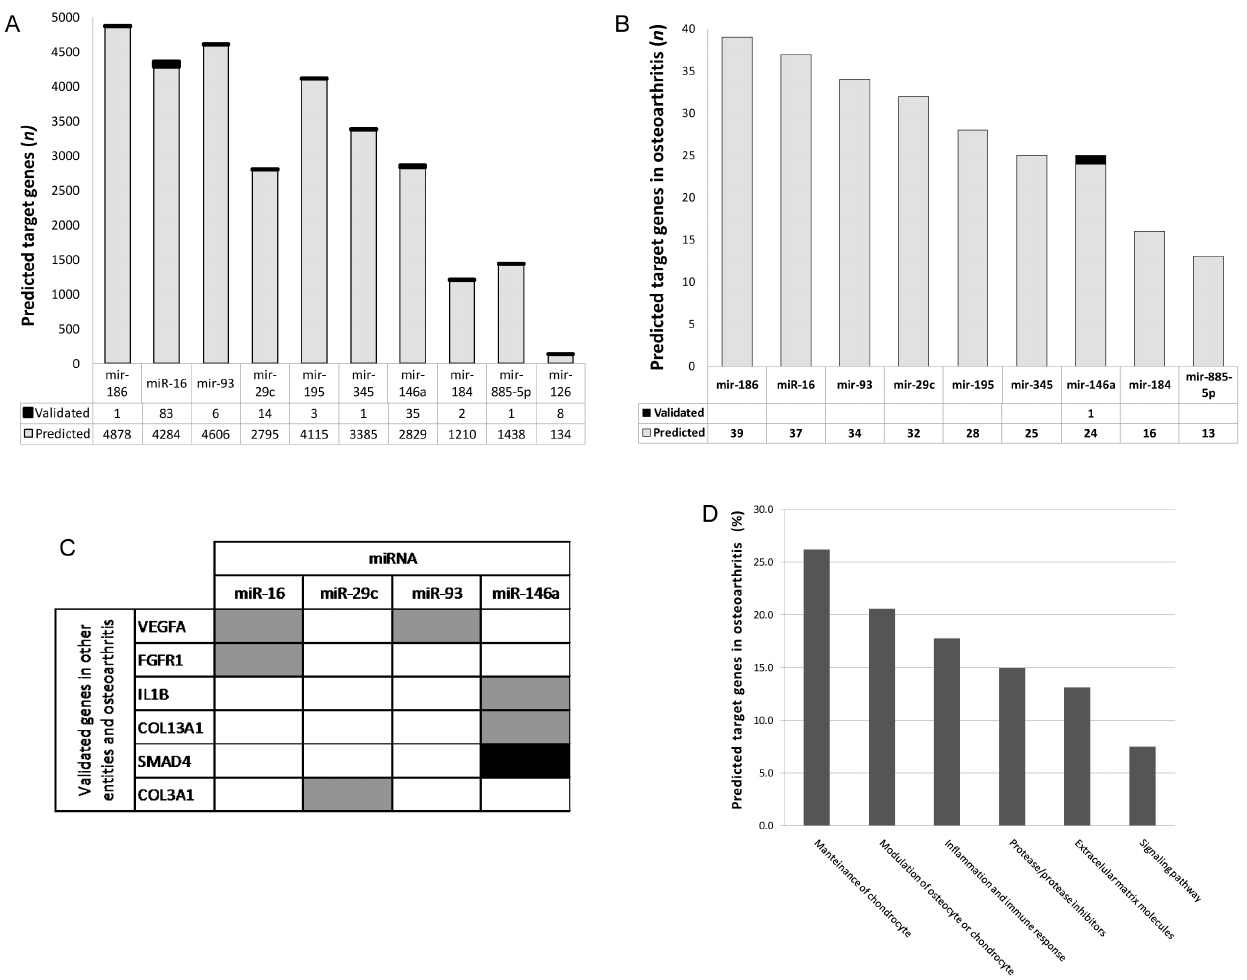
Figure 2. Transcripts targeted of microRNAs up-regulated in samples Osteoarthritis (OA). (A) Tabulation of the number of transcripts targeted of 10 miRNA; (B) Tabulation of the number of predicted targets for 150 genes involved in OA; (C) Predicted targets that have been confirmed previously in other entities and OA; (D) Percentage of predicted target genes involved in OA.